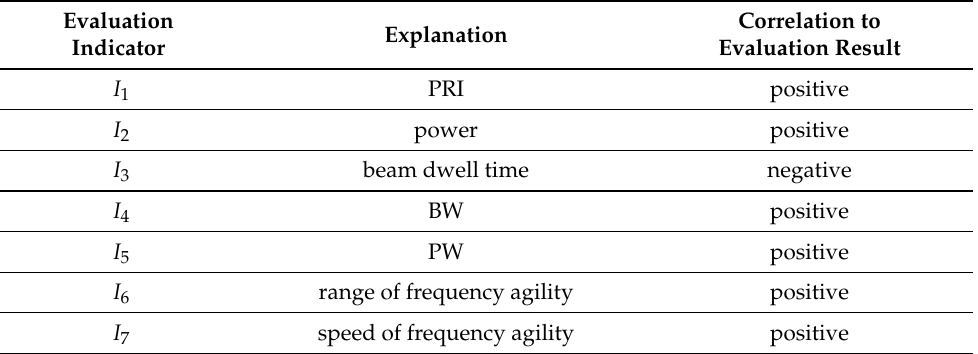
Table 3. Jamming effectiveness evaluation indicator set. The correlation to evaluation result is positive means that the greater the increase of this indicator, the better the jamming effectiveness. While the negative attribute means that the greater the decrease of this indicator, the better the jamming